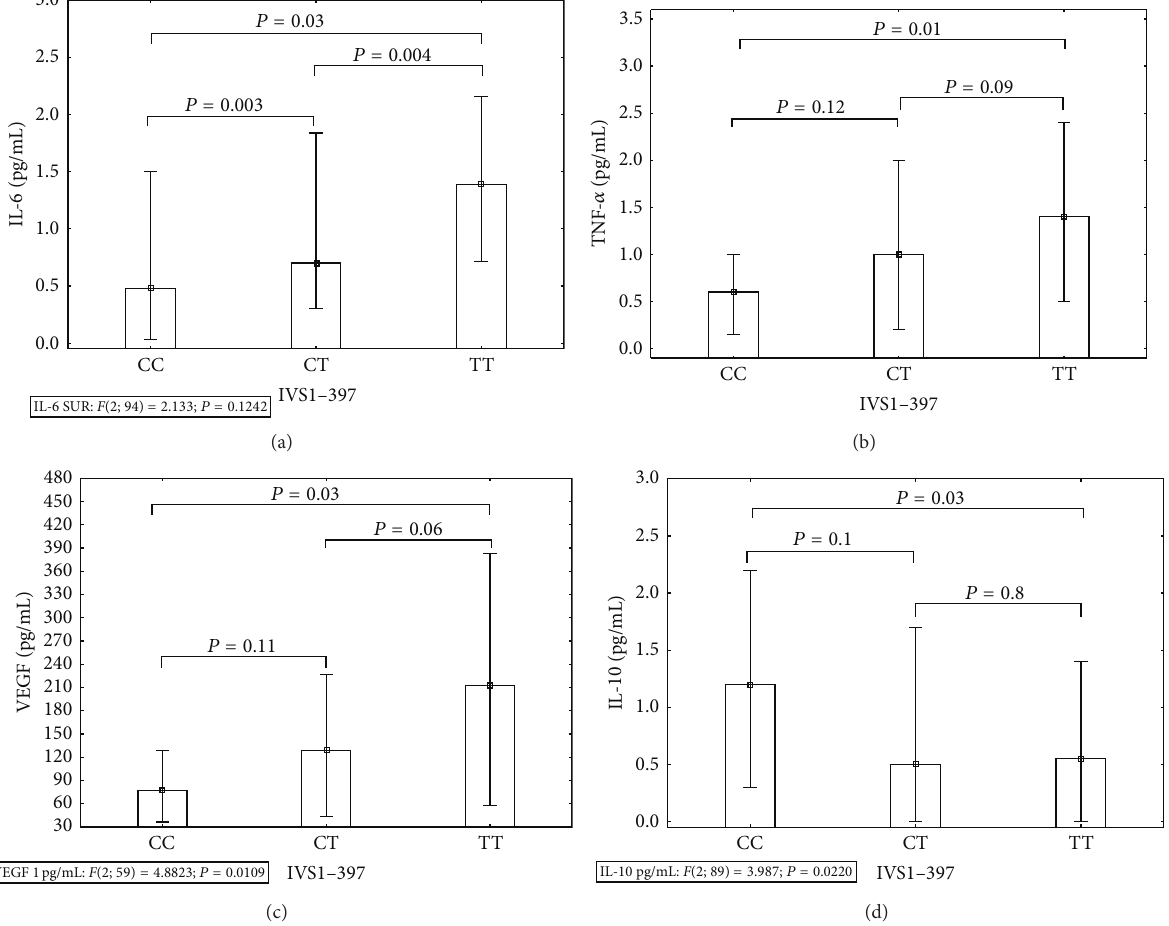
Figure 1: Serum levels of IL-6, TNF- 𝛼 , VEGF, and IL-10 in DM1 girls differing in the IVS1 − 397T > C polymorphism. In DM1 group the value of serum cytokines was measured by ELISA and analyzed according to different genetic variants of the IVS1 –397T > C estrogen receptor 𝛼 polymorphism. (a) The mean value (25/75 percentiles) of IL-6 was 0.48 (0.03/1.5), 0.7 (0.3/1.84), and 1.39 (0.7/2.157) pg/mL for CC, CT, and TT, respectively. (b) The mean value (25/75 percentiles) of TNF- 𝛼 was 0.6 (0.15/1), 1 (0.2/2), and 1.4 (0.5/2.4) pg/mL for CC, CT, and TT, respectively. (c) The mean value (25/75 percentiles) of VEGF was 76.89 (36.28/128.39), 128.45 (43.89/227.04), and 221.1 (57.4/382.76) pg/mL for CC, CT, and TT, respectively. (d) The mean value (25/75 percentiles) of IL-10 was 1.2 (0.3/2.2), 0.6 (0.0/1.7), and 0.5 (0.0/1.1)pg/mL for CC, CT, and TT, respectively. Differences were calculated by the Kruskal-Wallis ANOVA test and the post hoc NIR